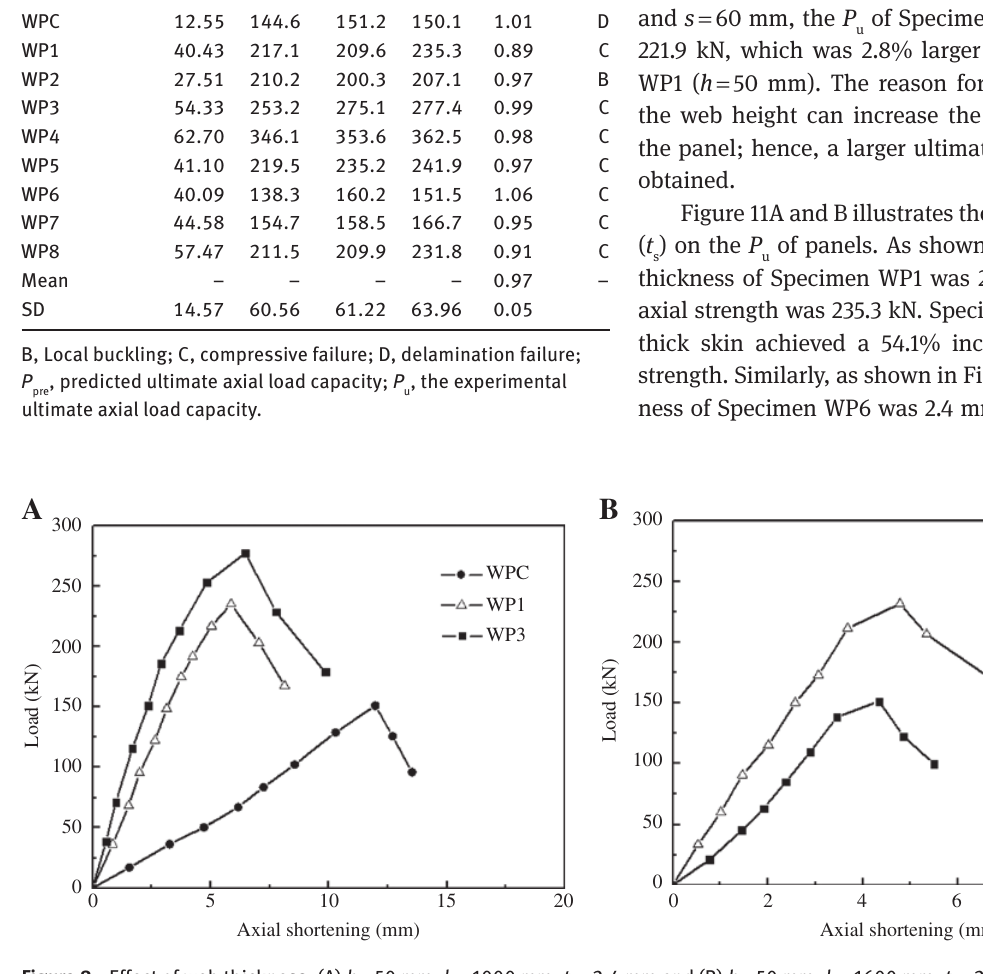
Figure 8: Effect of web thickness: (A) h = 50 mm, l